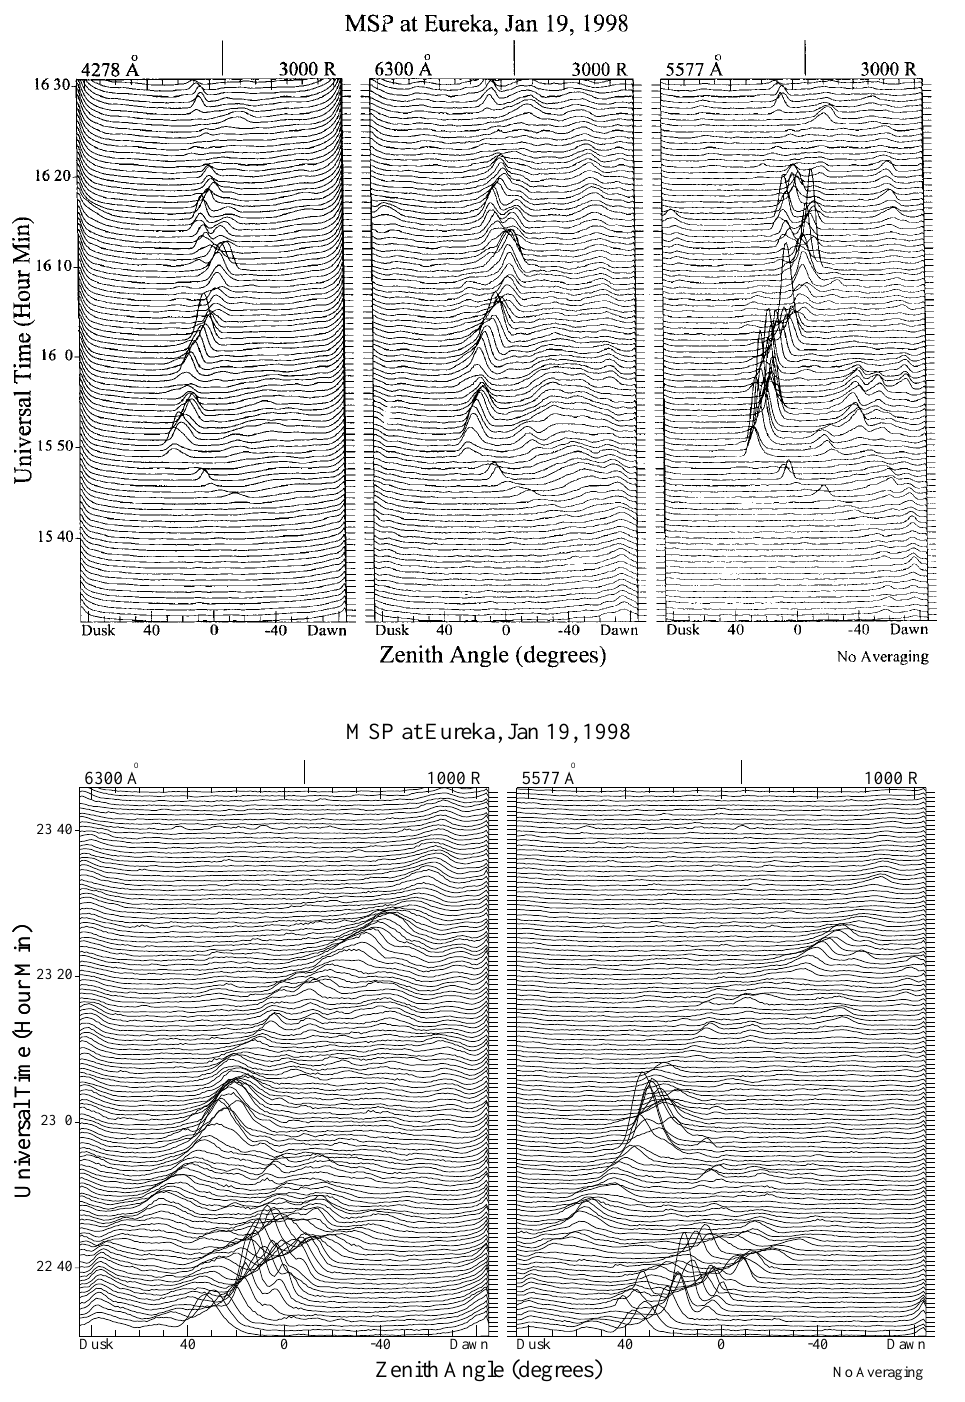
Fig. 14. Plots of MSP scans from 2220 to 2350 UT on Janu- ary